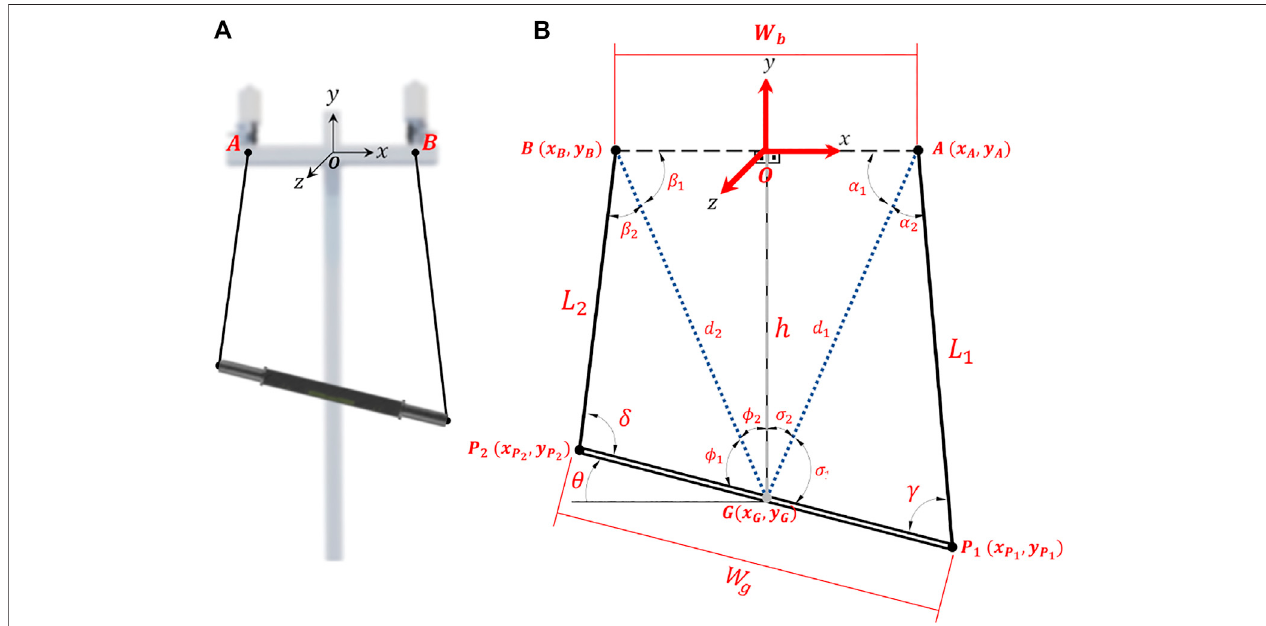
FIGURE 5 | Bimanual robot device: (A) computational model; (B) schematic to obtain the mathematical model.